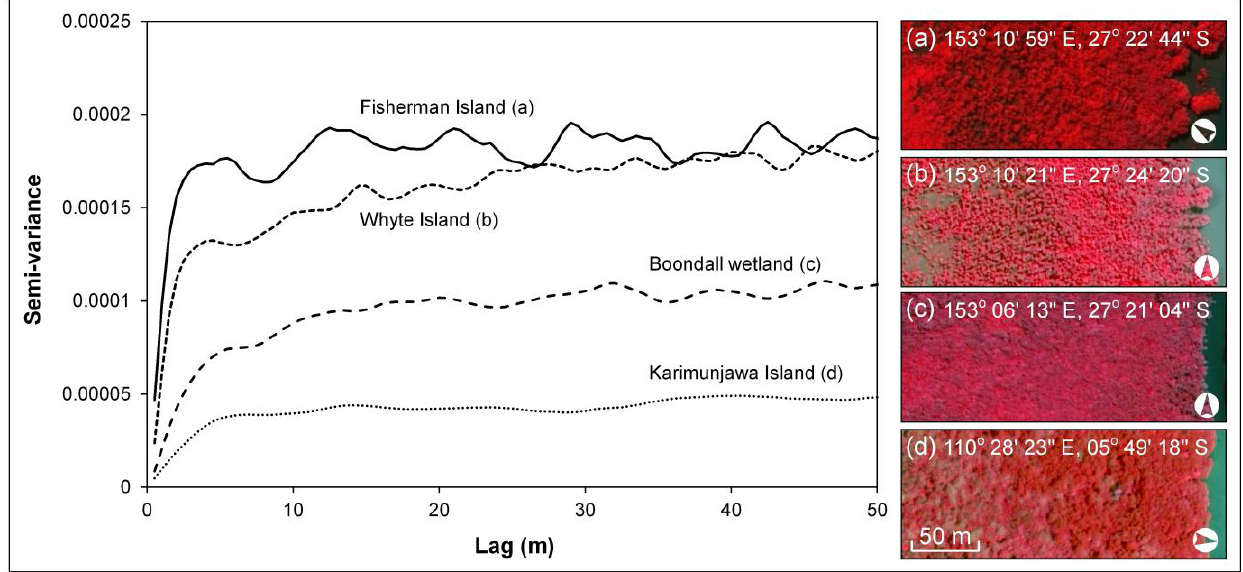
Figure 8. Subsets of green band semi-variograms, with up to 50 m lag distance, showing the variation of vegetation structure at different sites: ( a ) Fisherman Island, ( b ) Whyte Island, ( c ) Boondall wetlands and ( d ) Karimunjawa Island. Coordinates represent the approximate center of each